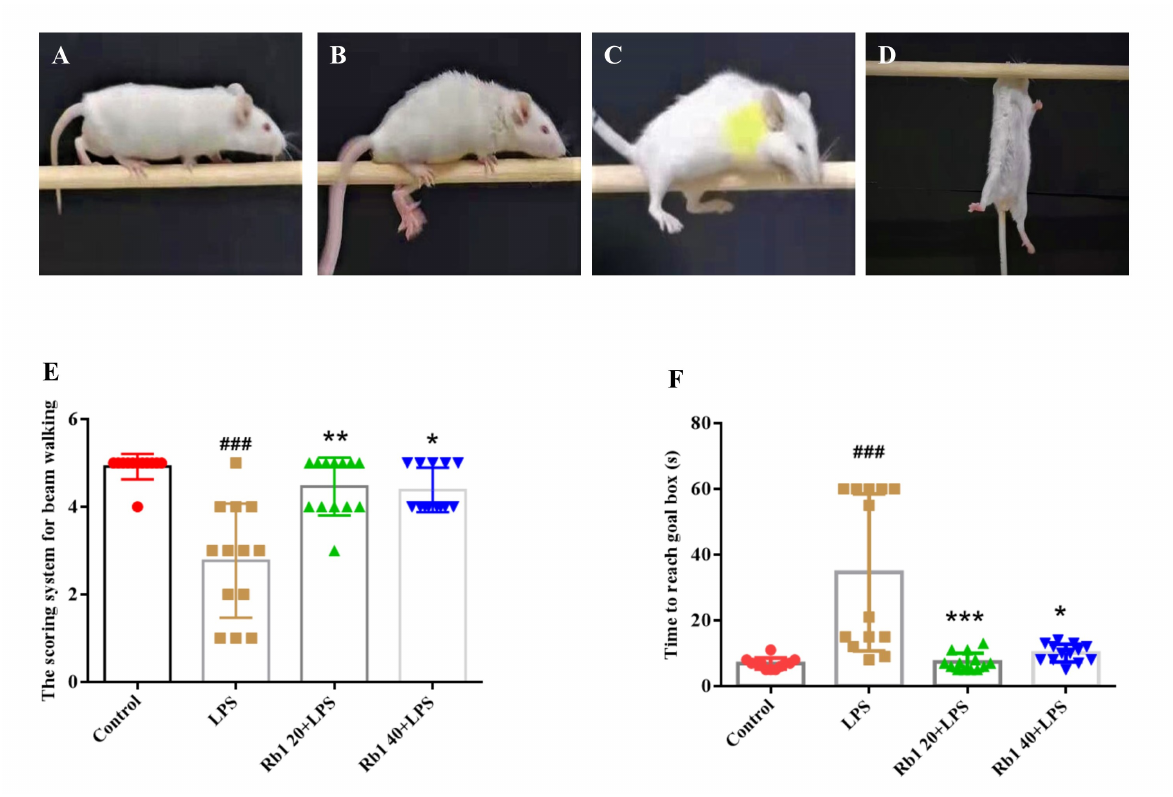
Fig.3. Rb1improvedLPS-inducedmotorcoordinationdeficits. The beam walking assay was used to determine motor coordination between 20 h and 24 h after LPS injection. The images illustrate the performance for the beam walking test, including traversing the beam normally (A), or hindfoot slips (B) with difficulties to place the hindfoot on the beam (C) or falls from the beam (D). The performance of the mice crossing the beam was as evaluated with scoring (E), and a higher score represents a better performance on the beam. The time crossing the beam to reach the goal box was also recorded (F). Data are represented as mean ± SD (n = 20). ### p < 0.001 versus the control group; * p < 0.05, ** p < 0.01, *** p < 0.001 versus the LPS